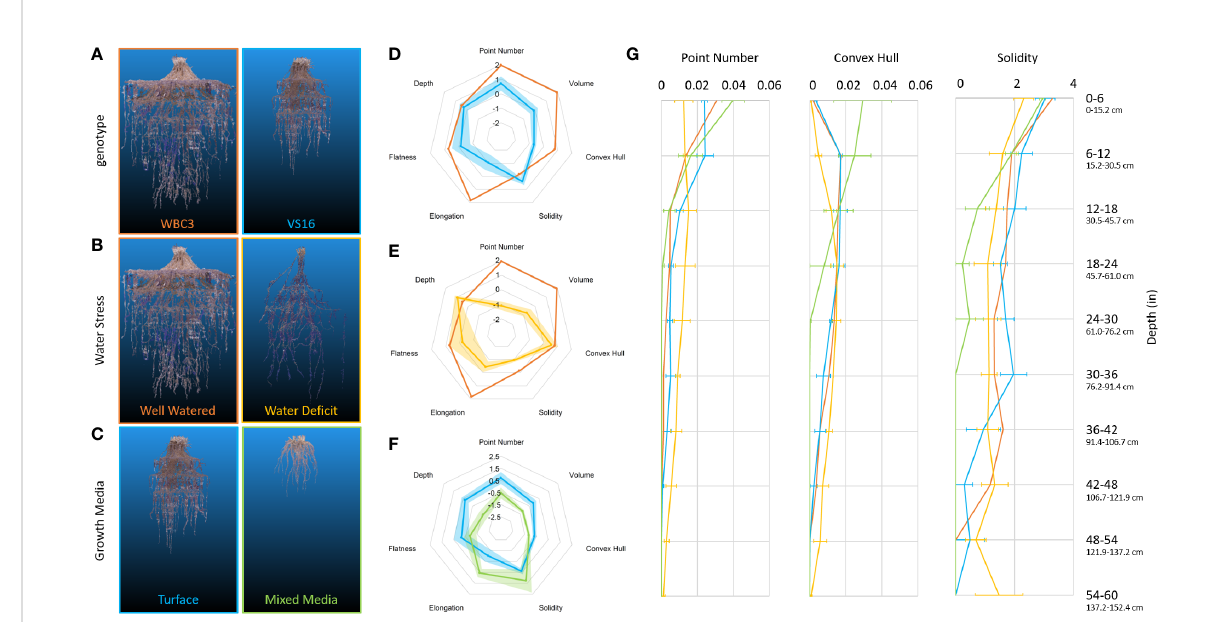
FIGURE 8 RSA traits of switchgrass affected by genetics and environmental conditions. Representative point clouds and extracted root traits of various G x E experimental conditions examinable via mesocosms. Genotypic comparison of WBC3 (orange) and VS16 (blue) when grown in well-watered turface (A, D) . RSA response of WBC3 to well-watered (orange) and water stressed (yellow) turface conditions (B, E) . RSA response of VS16 when grown in well-watered turface (blue) or a 3:1 potting mix to turface blend (green) (C, F) . Radar plots of data have all been standardized to allow comparison across treatments and traits, data shown are mean ± standard error. Point number (biomass proxy), convex hull, and solidity trait values (G) are presented for the entire depth of the growth media pro fi le (WBC3 WW turface, orange; VS16 WW turface, blue; WBC3 WS turface, yellow; VS16 WW mixed media, green). Values for solidity were transformed by log(x*10000) for data